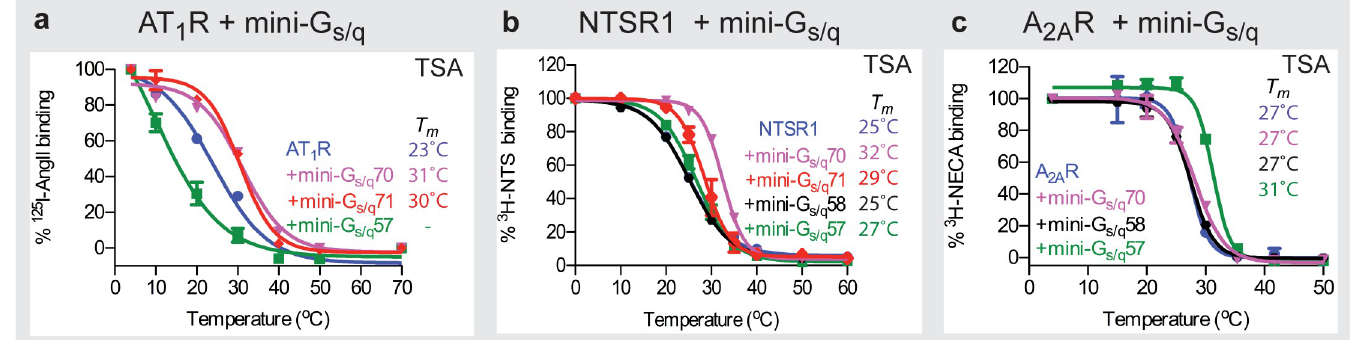
Fig 5. Thermostability assaysof various complexes between mini-G s/q chimerasand GPCRs. ( a ) Thermostability of unpurifieddigitonin-solubilized, 125 I-AngII-bound AT 1 R ( T m values in parentheses): blue circles, no mini-G s/q (23 ± 0.4˚C); green squares, mini-G s/q 57 ( T m not determined); magenta inverted triangles, mini-G s/q 70 (31 ± 1˚C); red triangles, mini-G s/q 71 (30 ± 0.8˚C). ( b ) Thermostability of unpurifiedDDM-solubilized, 3 H-NTS-boundNTSR1: blue, no mini-G s/q (25 ± 0.4˚C); green squares, mini-G s/q 57 (27 ± 0.7˚C); black circles, mini-G s/q 58 (25 ± 0.4˚C); magentainverted triangles,mini-G s/q 70 (32 ± 0.3˚C); red diamonds,mini-G s/q 71 (29 ± 1.1˚C). ( c ) Thermostability of unpurifiedDM-solubilized, 3 H-NECA-boundA 2A R: blue circles, no mini-G s/q (27 ± 0.3˚C); green squares, mini-G s/q 57 (31 ± 0.3˚C); black circles, mini-G s/q 58 (27 ± 0.5˚C); magenta invertedtriangles, mini-G s/q 70 (27 ± 0.2˚C). In all panels,data (n = 3) were analysedby nonlinearregressionand apparent T m values were determined from analysisof the sigmoidaldose-response curves fitted with values shown as mean ± SEM. Curves shown are from a representative